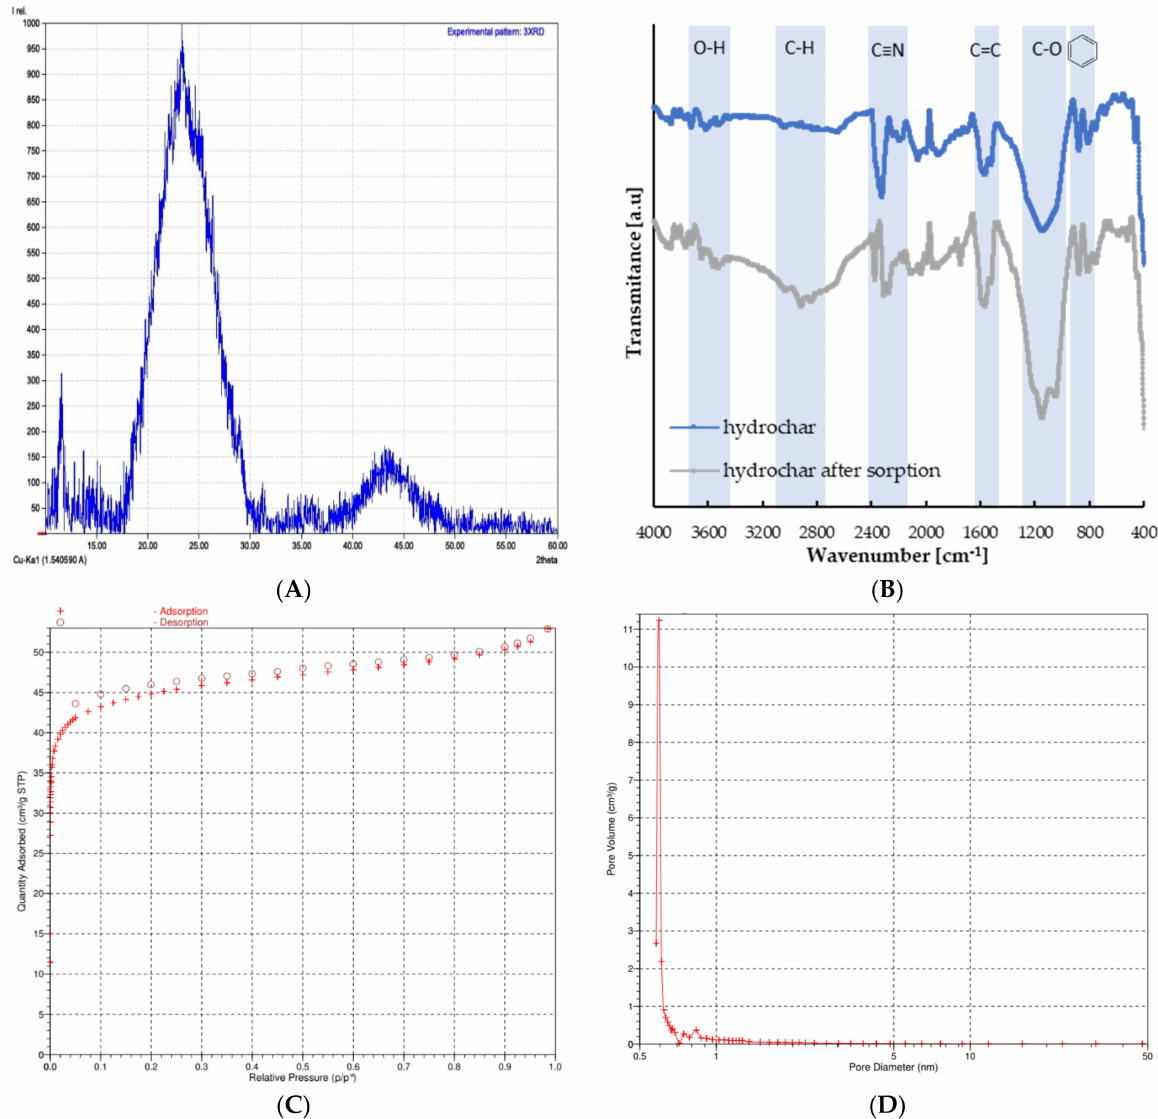
Figure 2. ( A ) XRD diagram of activated hydrochar; ( B ) ATR–FTIR of hydrochar before and after the mercury sorption process; ( C ) low temperature nitrogen sorption/desorption isotherm; ( D ) pore size